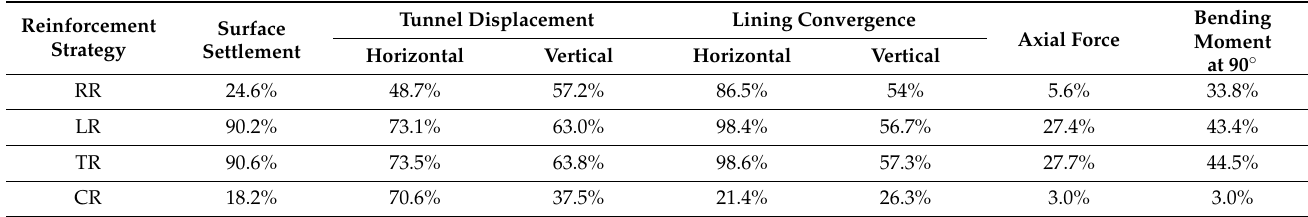
Table 3. Comparison of improvement